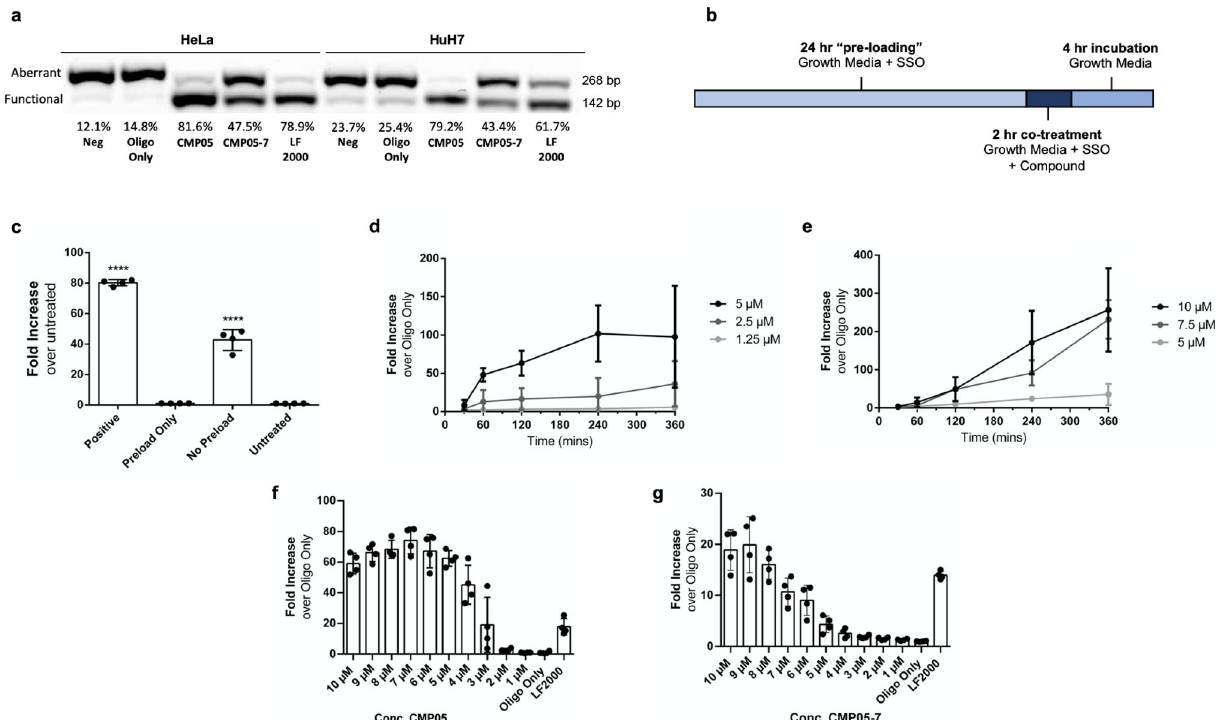
Fig. 3 Characterization of endosomolytic compound dose and time-dependent effects. a Representative RT-PCR with gel analysis used to detect aberrant or functional mRNA copies. Gel images were quantitated using Quantity One (BioRad) software. Values of functional mRNA are reported as a percentage of total mRNA. b Schematic of the treatment plan. Cells are seeded in DMEM + 10% FBS (growth media) with added SSO. After 24 h, endosomolytic compound diluted in growth media is added to the desired fi nal concentration. After 2 h of co-treatment, media is removed, cells are washed with PBS, and then replaced in growth media for 4 h. Media is then removed and cells are lysed in accordance with the next experimental steps. c Functional SSO activity from different treatment plans of CMP05. The “ positive ” group underwent the previously described treatment. The ” preload only ” group was treated with 1 µ M SSO for 24 h and then media was changed to growth media with 5 µ M compound for 2 h. The ” no-preload ” group was treated with 1 µ M SSO and 5 µ M CMP05 simultaneously for 2 h. Values are reported as fold increase over untreated cells. The “ Positive ” and “ No Preload ” groups are each signi fi cantly higher than the “ Untreated ” and “ Preload Only ” groups ( P < 0.001). Data come from n = 4 experiments. d , e HeLa_Luc705 cells were co-treated with 1 µ